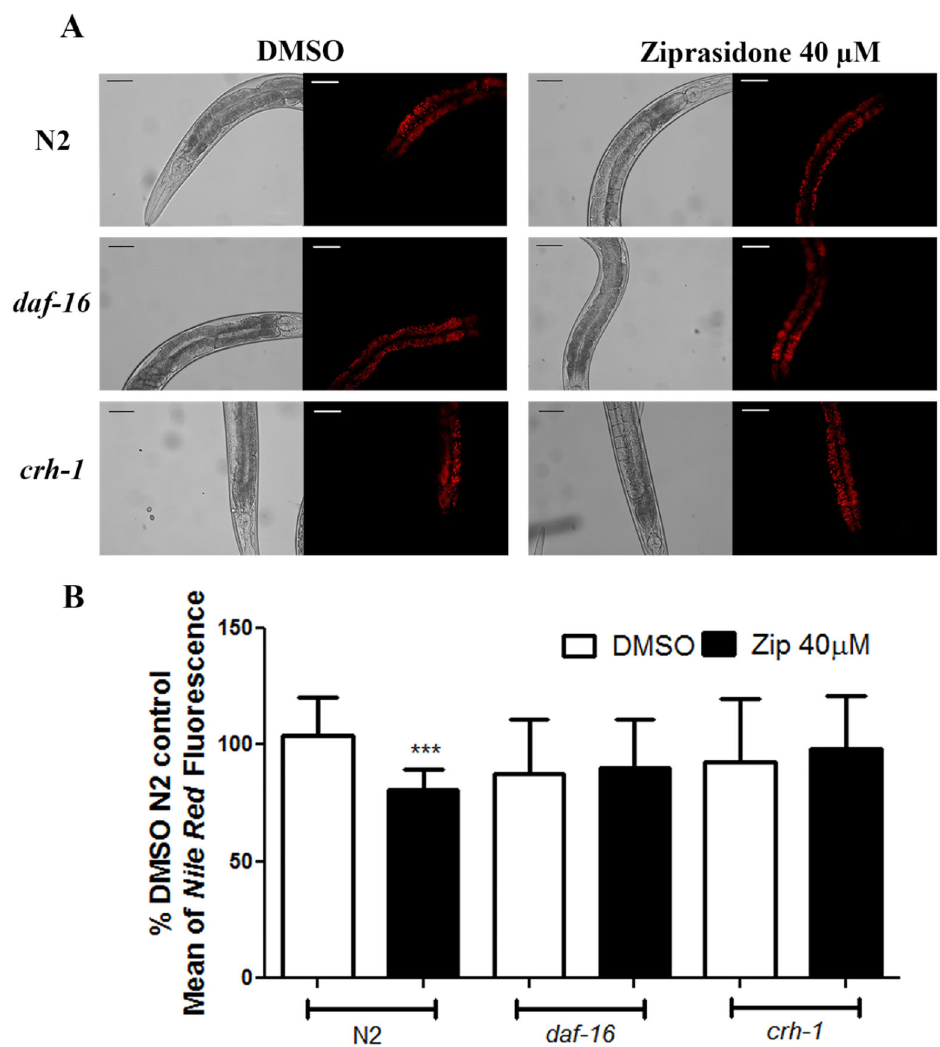
Figure 11. Recover of lipid profile through Nile Red labeling in mutants to daf-16 and crh-1 transcription factors after Ziprasidone treatment (40 µM). (A) Representative images of Nile Red fluorescence and (B) fluorescence amount in C. elegans mutants ( daf-16, crh-1 ) and wild-type (N2). The results were expressed in percentage of control (DMSO 0.16% in Acetic acid (1:10 000)). ***p<0.0001, statistically different compared to the control by one way ANOVA with Bonferroni correction for post hoc multiple comparisons (mean of fluorescence, SD,